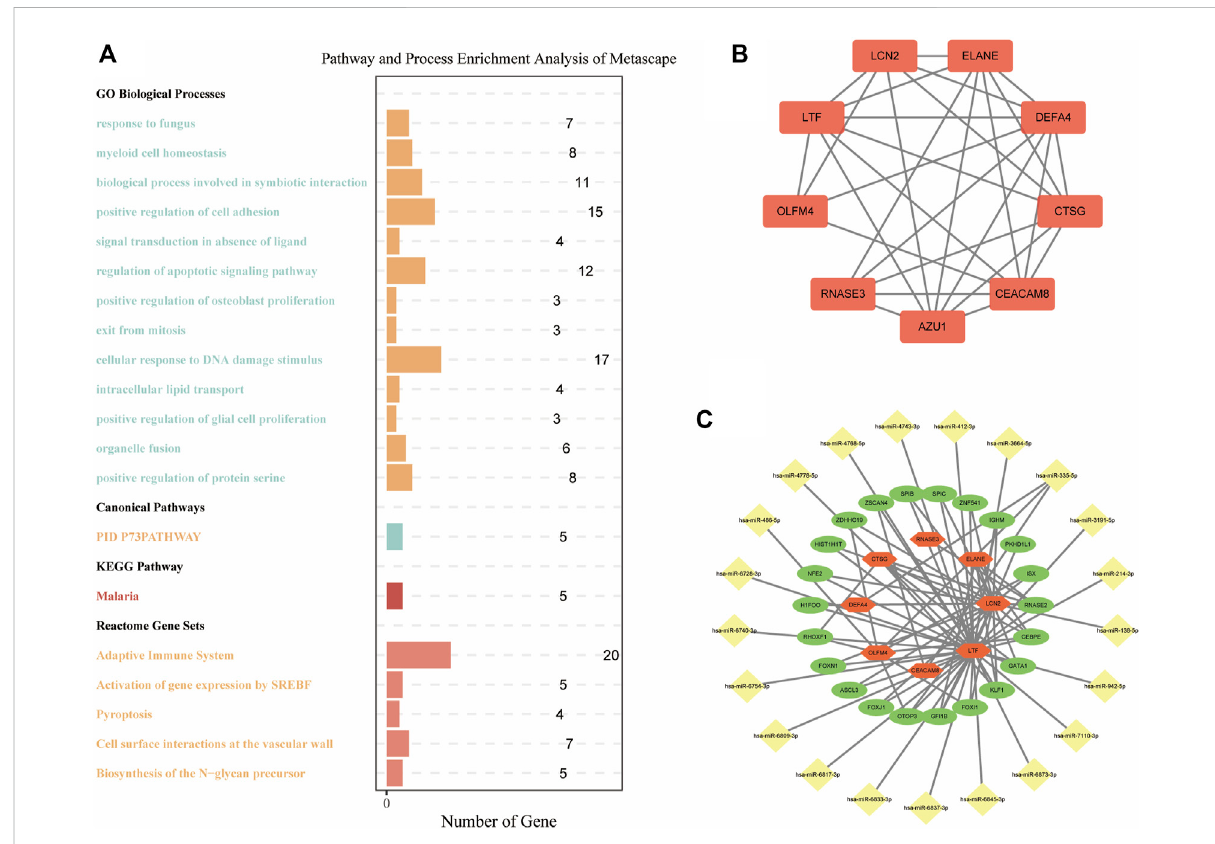
FIGURE 6 Functional enrichment and mRNA – miRNA – TF networks. (A) Pathway and process enrichment analysis of DEGs between m7G clusters. (B) PPI network of DEGs between m7G clusters. (C) mRNA – miRNA – TF networks of DEGs between m7G clusters. TF: transcription factor; PPI: protein – protein interactions; DEGs: differentially expressed